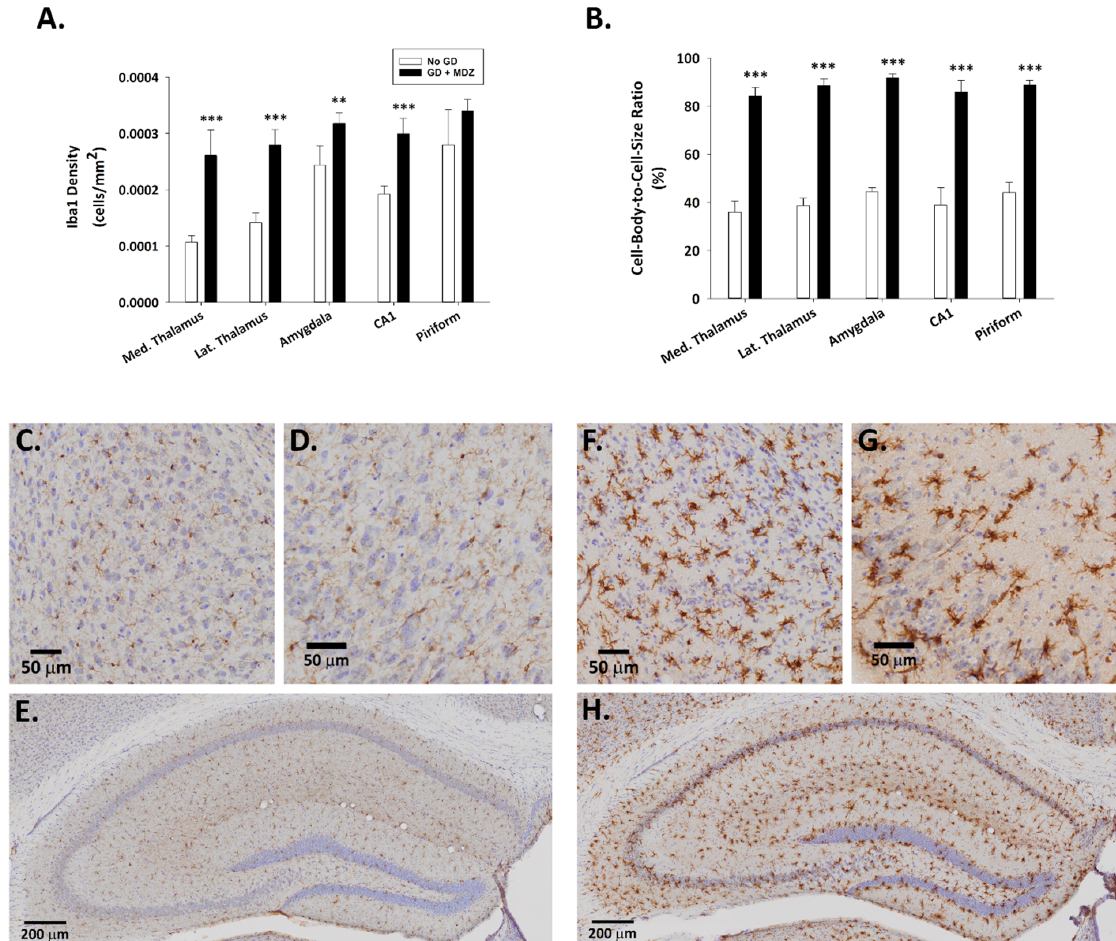
Figure 3. Effect of soman-induced status epilepticus and delayed midazolam (3 mg/kg; SC) treatment on microgliosis and microglial activation in KIKO mice. Soman-exposed (SC) KIKO mice were treated with midazolam 15 min after seizure onset. At 24 h after saline or GD exposure, mice were perfused and brains were collected for immunohistochemical processing with and antibody against Iba1 to visualize microglia. Cresyl violet was used for the localization of anatomical landmarks. Measures of ( A ) cell density and ( B ) cell-body-to-cell-size ratio were estimated in the medial (Med.) thalamus, lateral (Lat.) thalamus, amygdala, amygdala, CA1 region of the hippocampus, and layer 3 of the piriform cortex of GD-exposed mice given midazolam (GD + MDZ; n = 5) and no agent controls (No GD; n = 4). Representative images taken with a 0.75 NA 20X objective are shown from ( C – E ) control mice and ( F – H ) soman-exposed mice. Close-ups of the ( C , F ) amygdala, ( D , G ) piriform cortex, and ( E , H ) hippocampus are shown. ** p < 0.01, *** p < 0.001, compared to No GD control group.